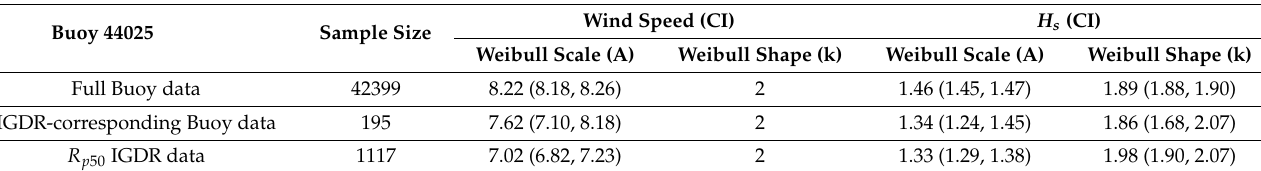
Table 6. Weibull shape and scale values with 95% confidence interval in parentheses for satellite and buoy data around Buoy 44025.